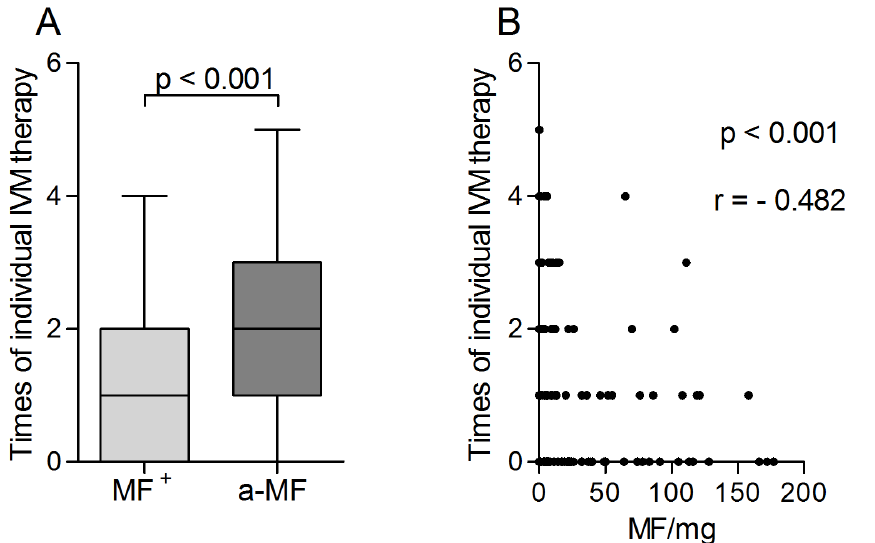
Figure 8. Individual IVM therapy is higher in a-MF + individuals. Infected individuals completed a study questionnaire which included a section about the number of times they had taken IVM (IIT). The data are displayed as box whiskers with median, interquartile ranges and outliers (A). Statistical significances between the indicated groups were obtained after Mann-Whitney tests and significant differences are indicated in the figures. IIT was then correlated to the amount of skin residing microfilariae (B). Correlations were determined using the Spearman correlation test.